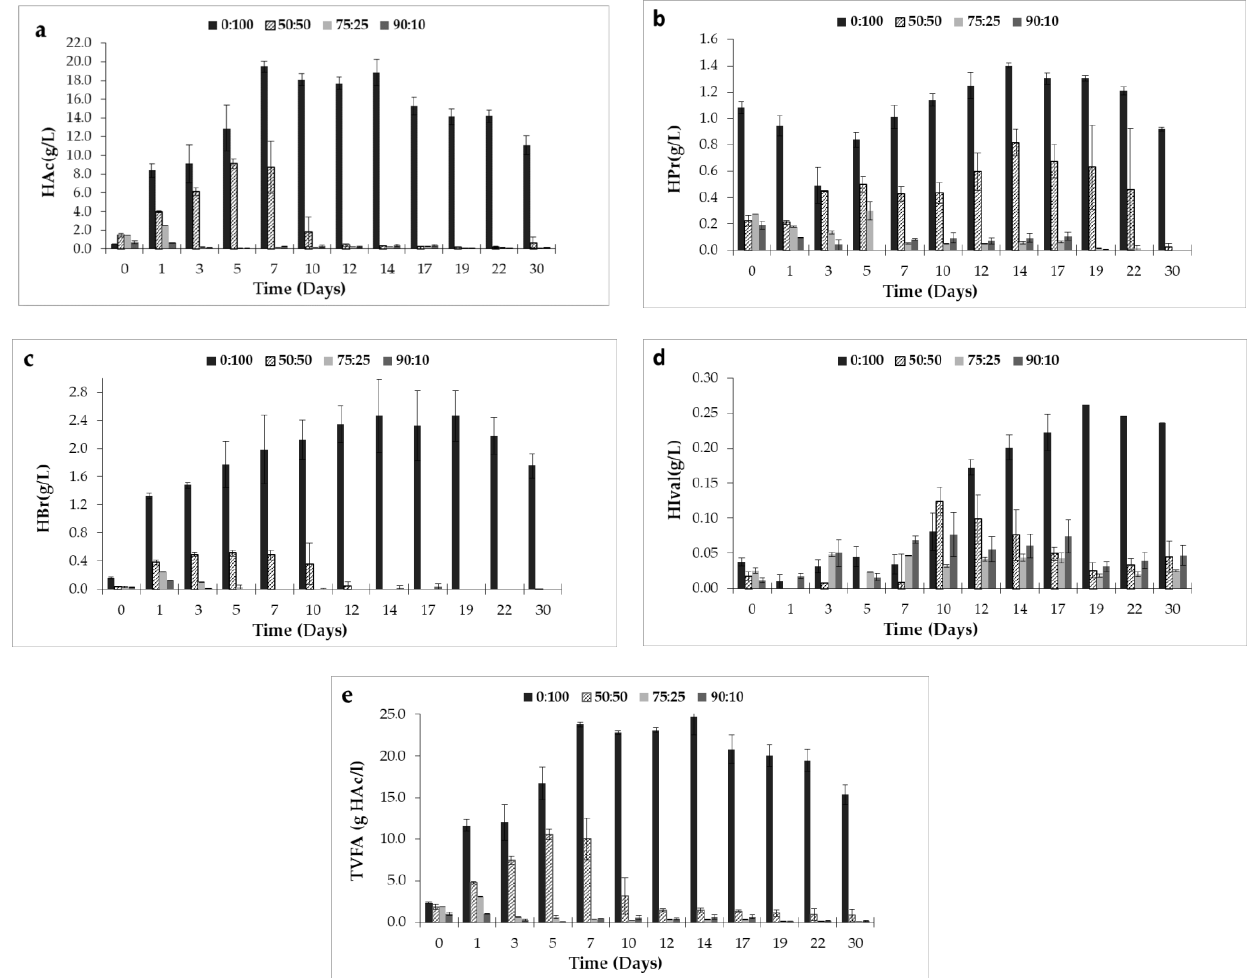
Figure 2. Comparison of the evolution of the individual VFAs (acetic, propionic, butyric, and valeric acids) and of the total acidity (TVFA) in the reactors. ( a ) Evolution of the acetic acid (Hac). ( b ) Evolution of the propionic acid (HPr). ( c ) Evolution of the butyric acid (HBr). ( d ) Evolution of the valeric acid (HIval). ( e ) Evolution of total volatile fatty acidity (expressed as g Hac/L).